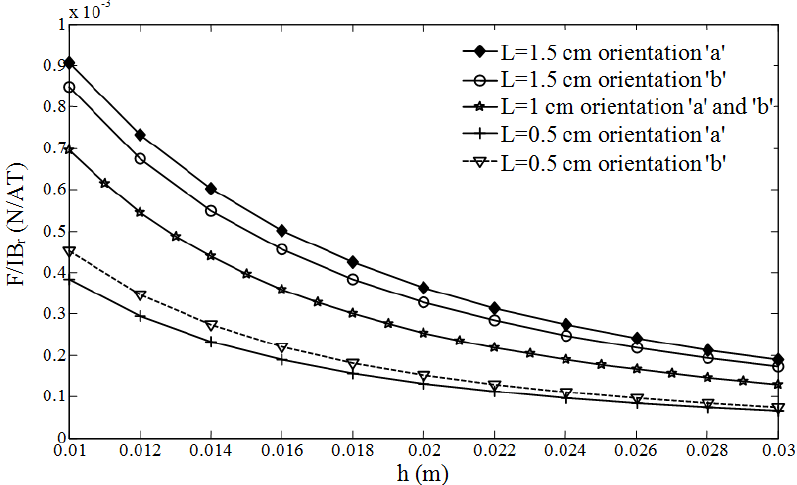
Figure 7. Theoretical force per unit current and unit residual flux density for cuboid magnets.